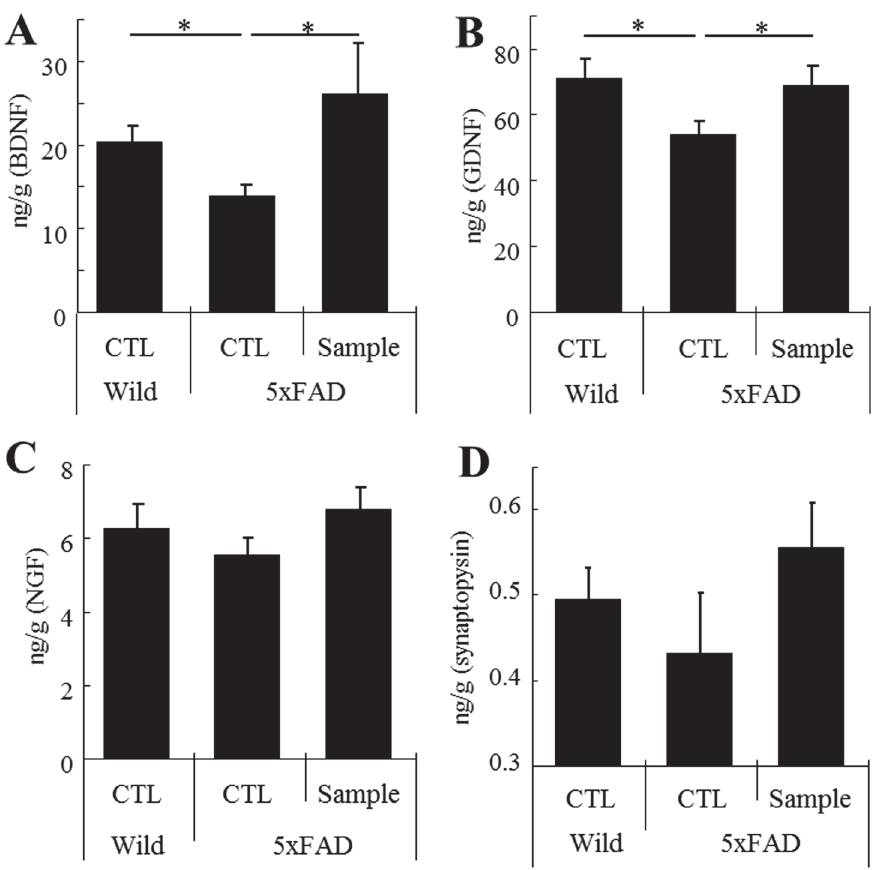
Fig 2. Quantification of neurotrophic factors and synaptic markers in the hippocampus by ELISA. A , B and C , Measurement of BDNF, GDNF and NGF, respectively, in the hippocampus. D , Measurement of synaptophysin in the hippocampus. Error bars represent means ± SEM of 11 mice per group. * p < 0.05.